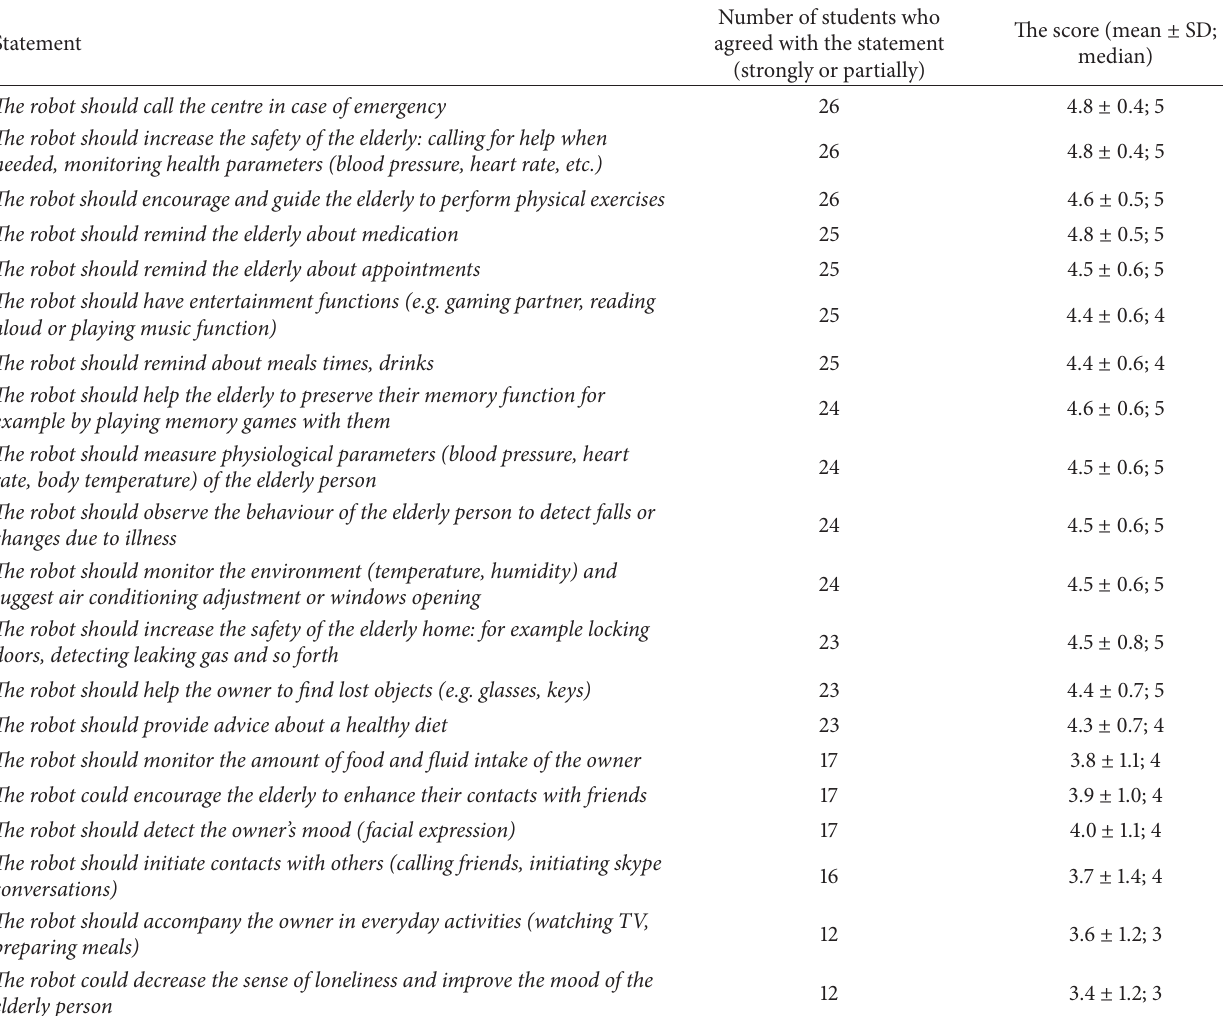
Table 1: Quantitative analysis of the opinions of occupational therapy students related to the statements about the role of the robot in the care for older people, arranged by number of students who agreed with the statement and mean score